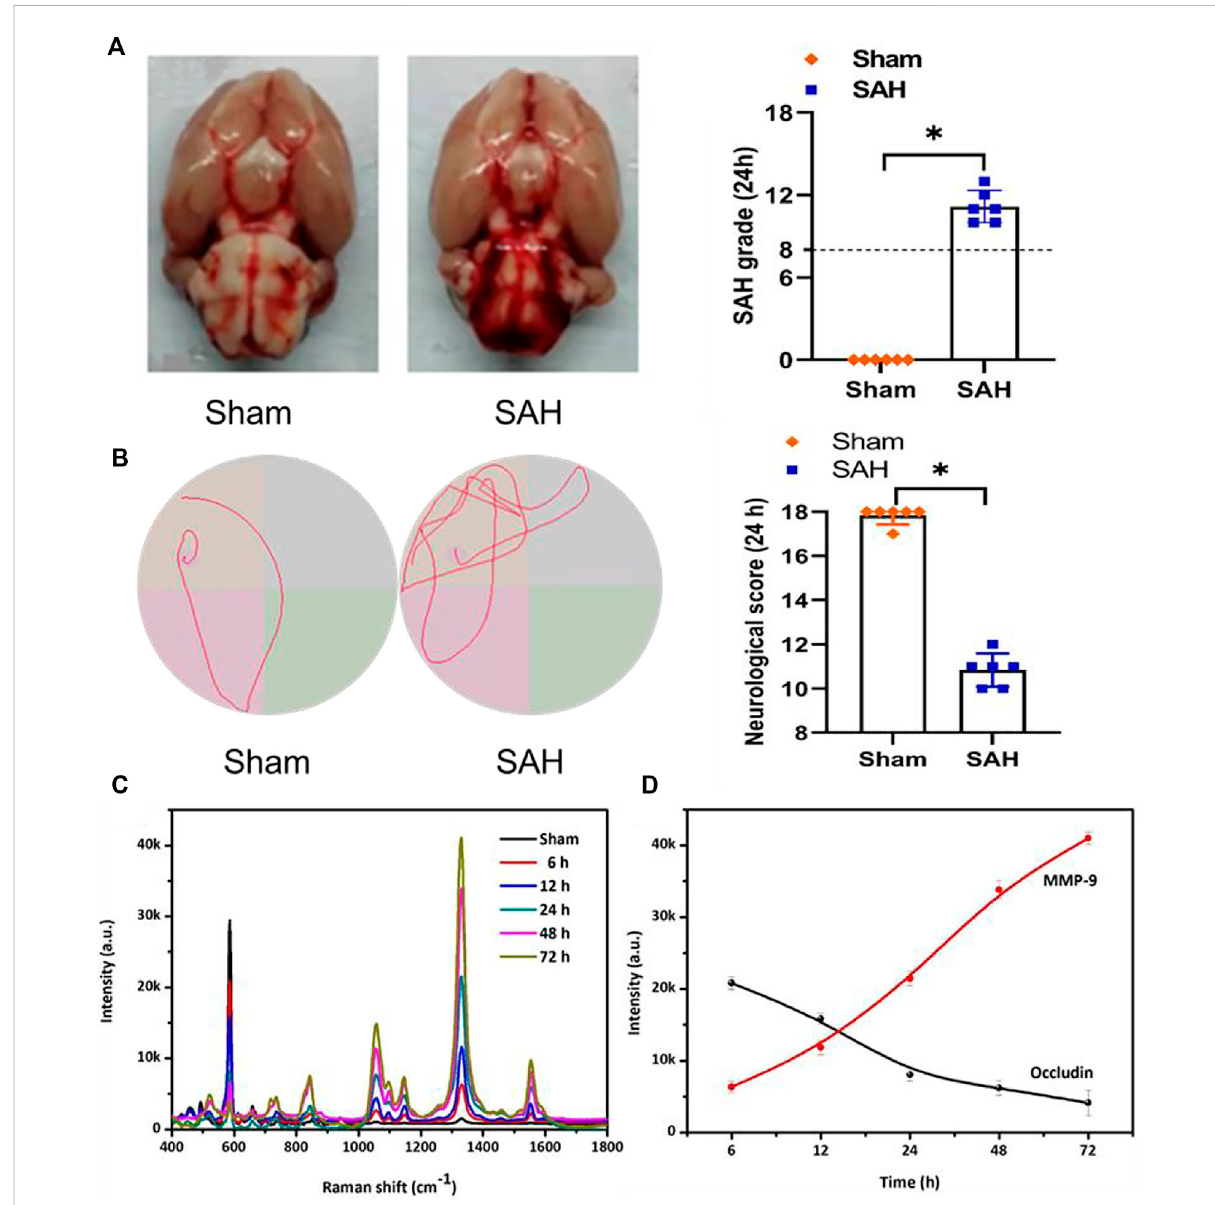
dependent concentrations of occludin and DTNB corresponding to the time-dependent concentrations of MMP-9 in the blood samples of the rat SAH